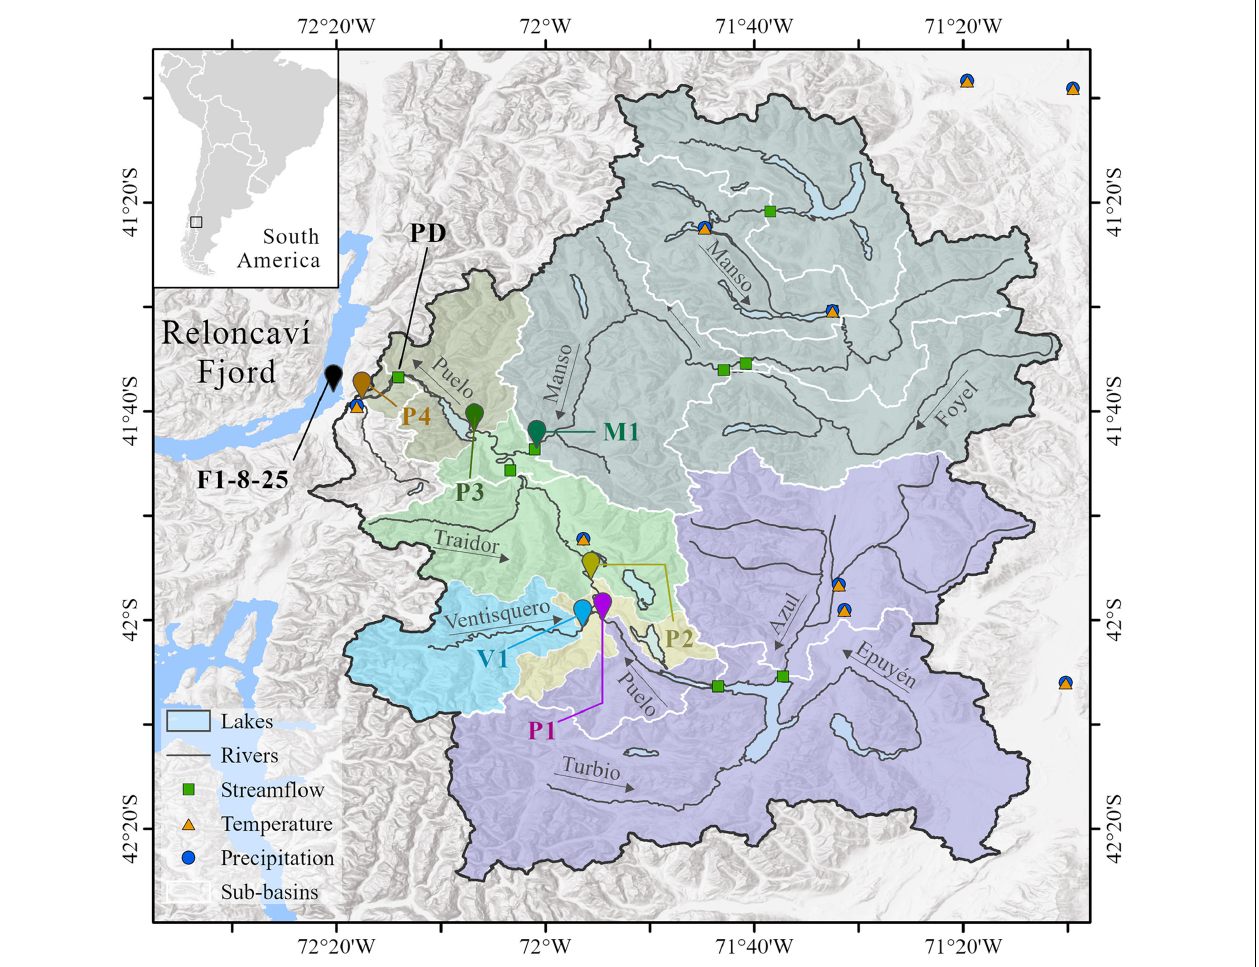
FIGURE 1 | Study area composed of the Puelo River Basin and the Reloncaví Fjord. Within the basin, the names and arrows indicate the principal rivers of the Puelo River drainage network. Geometric symbols indicate the fluviometric and meteorological stations used in the study. Vignettes indicate the sampling points in the Puelo River drainage network (P1, P2, P3, P4, V1 and M1) and Reloncaví Fjord (F; depths 1, 8, and 25 m). The colored polygons represent the sub-basins for each sampling point. The white lines indicate the sub-basins used in the hydrological modeling (section “Hydrologic Modeling of